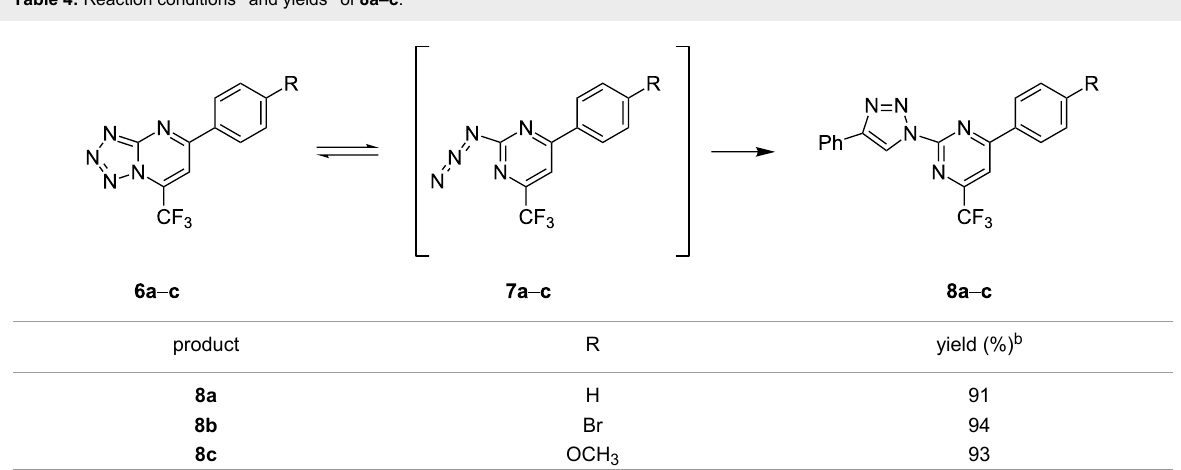
Table 4: Reaction conditions a and yields b of 8a–c .